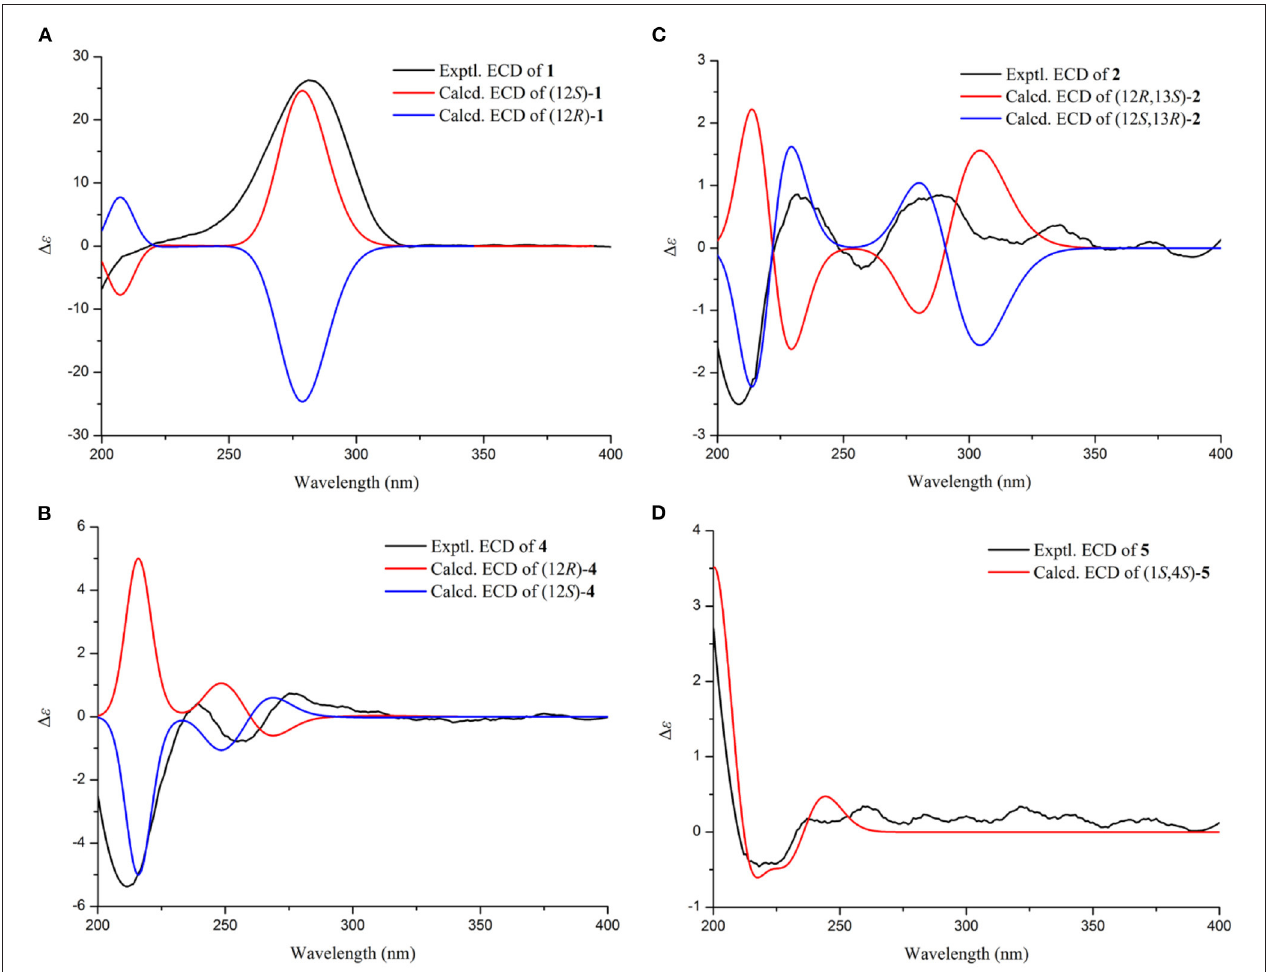
FIGURE 2 | Experimental and calculated ECD curves for 1 (A) ; 2 (B) ; 4 (C) ; 5 (D) .